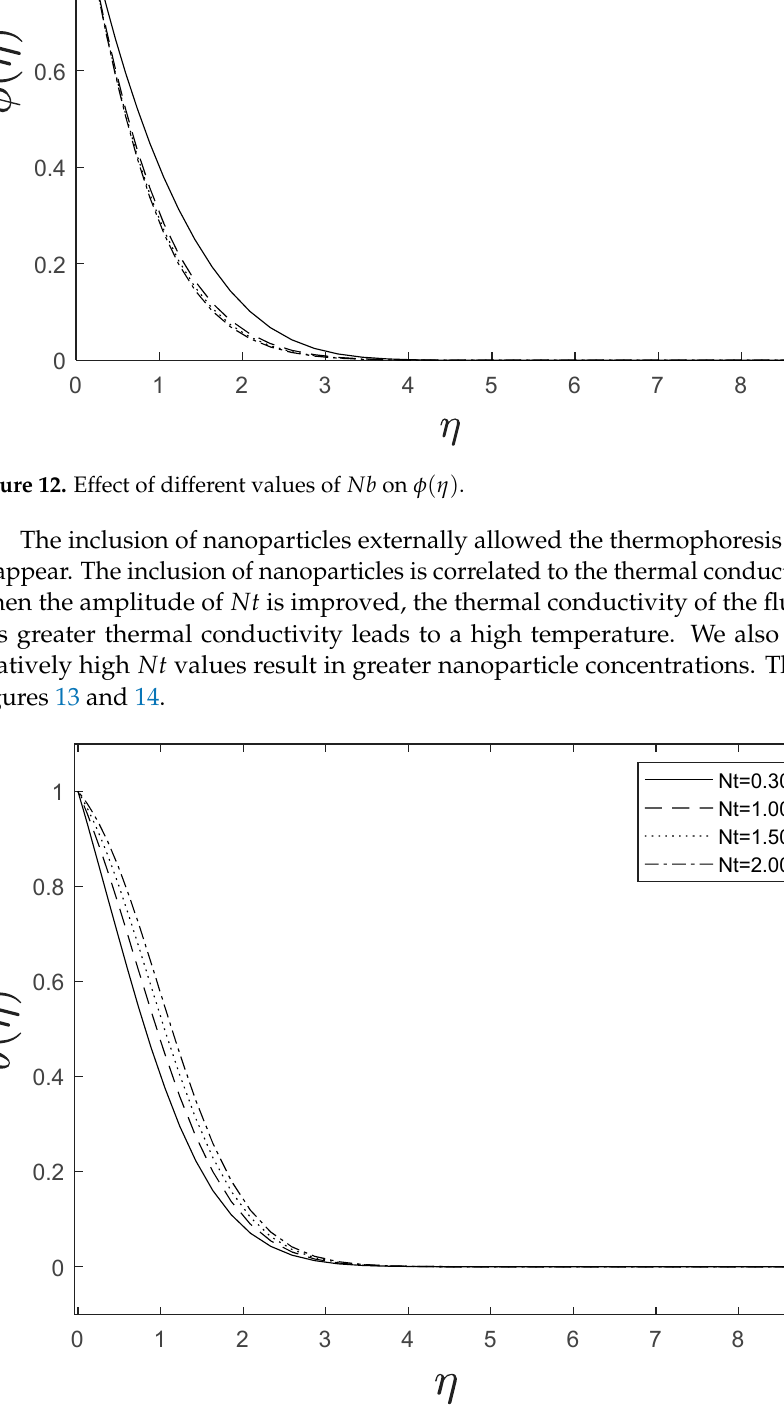
Figure 13. Effect of different values of Nt on θ ( η )